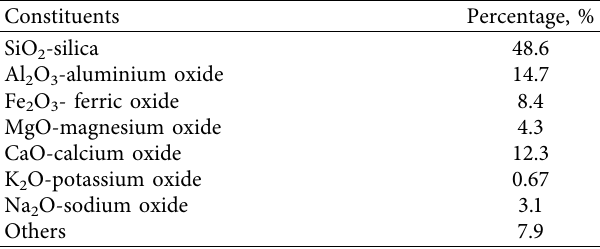
Figure 8: CBR of clay and blends of clay plus RHA and NS. Table 7: Chemical composition of expansive clay (C) from X-ray (ASTM D5381) fuorescence analysis.